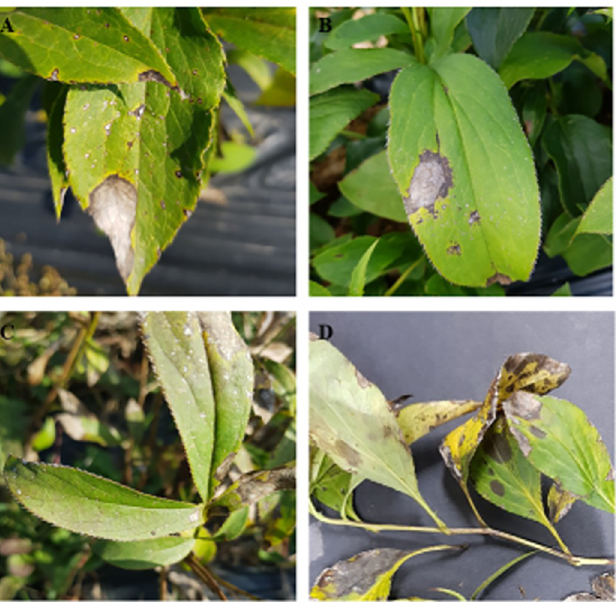
Fig 1. Symptoms of OLA anthracnose on leaves in the field. A-C: Symptoms of big necrotic lesion and small spots. D: Coalesce of small and big spots.